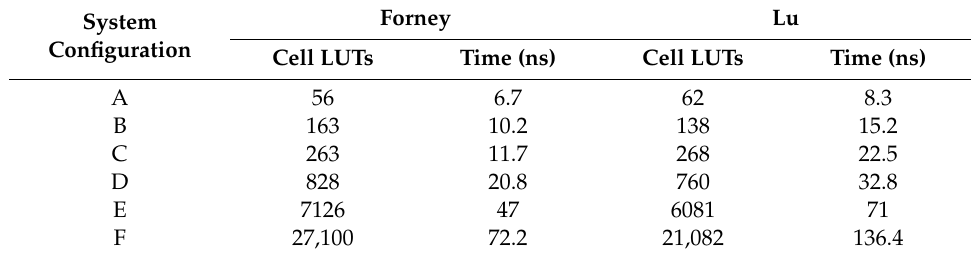
Table 4. Field programmable gate array (FPGA) implementations results. LUTs, look-up tables.